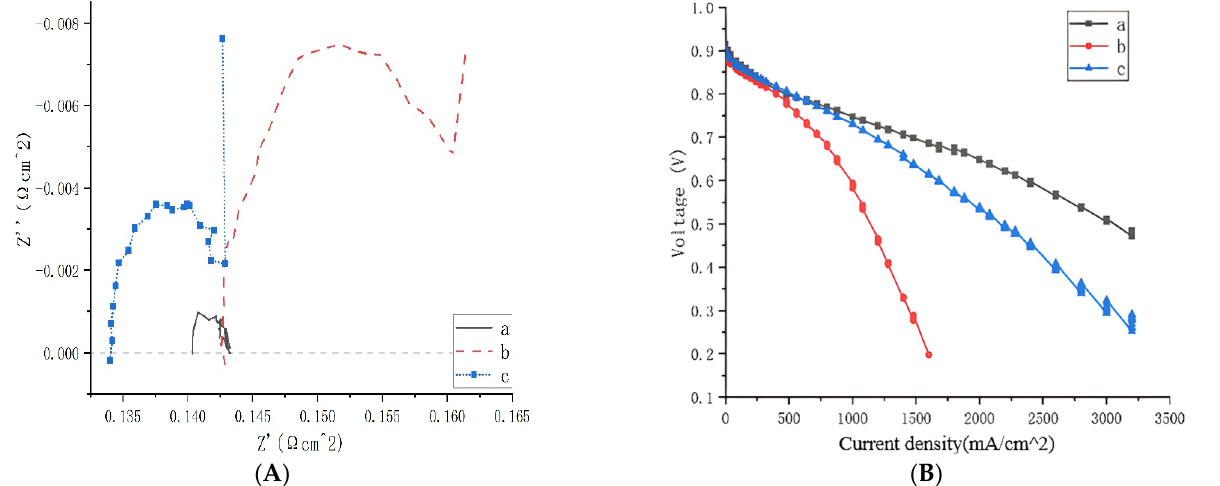
Figure 5. Electrochemical test curve ( A ) impedance spectrum. The current density is 1500 mA/cm 2 , the frequency is 100–104 mHz, and ( B ) is the single-cell cathode polarization curve, The current sweep range is 0–2 A, the scan rate is 50 mA per second, and the SLPM of oxygen is 3. It is marked in the picture that (a ~ b ~ c) are the initial carbon cloth, hydrophobic carbon cloth, and hydrophilic carbon cloth, respectively.